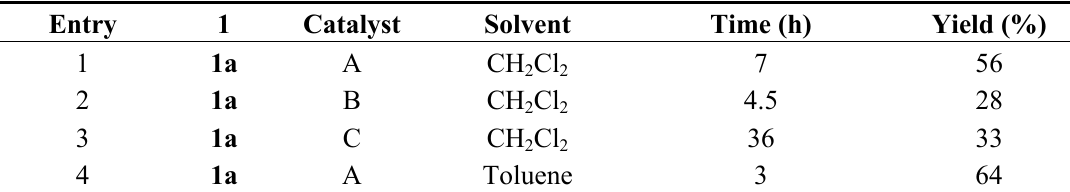
Table 1. CM of 1a with 2